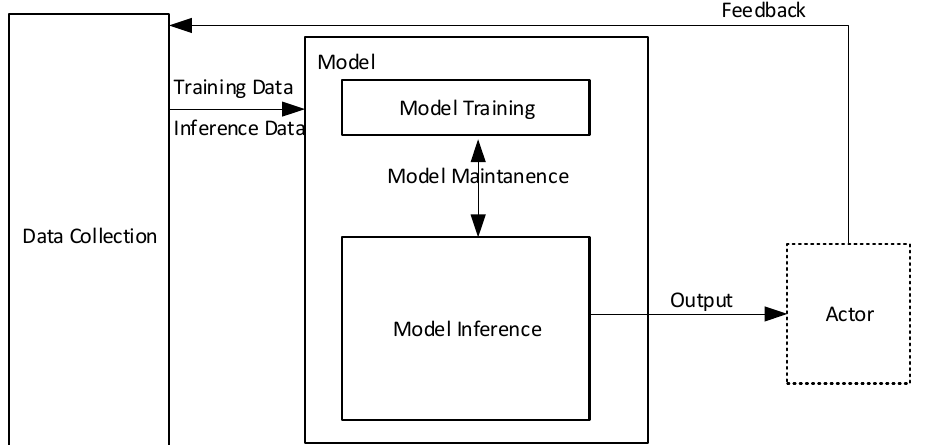
Figure 4. Functional framework for RAN intelligence [10].